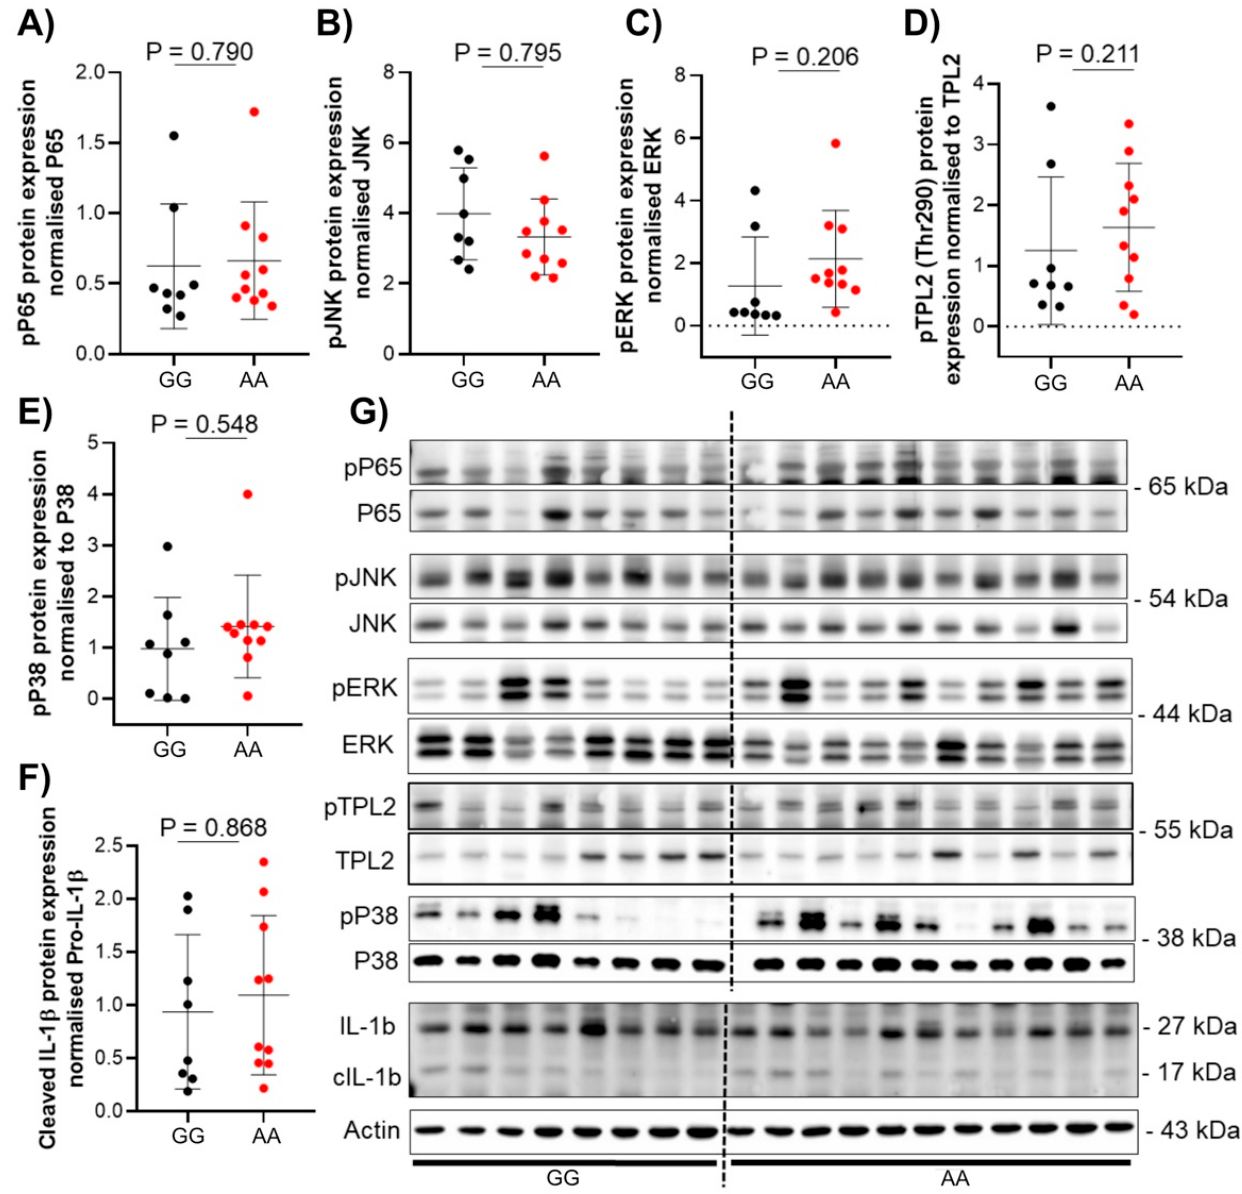
Figure 3. Protein expression of TPL2 downstream pathway in UC patients with or without rs1042058 TPL2 variant. Analysis of protein expression in human colon biopsies was performed using western blot from UC patients with or without rs1042058 TPL2 variant. ( A – F ) Dots in the graph represent individual patients. Red circles represent patients with the rs1042058 TPL2 variant, and black circles represent patients without the rs1042058 TPL2 variant. ( G ) Each lane in the Western blot image represents an individual patient. Error bars represent means ± SD.